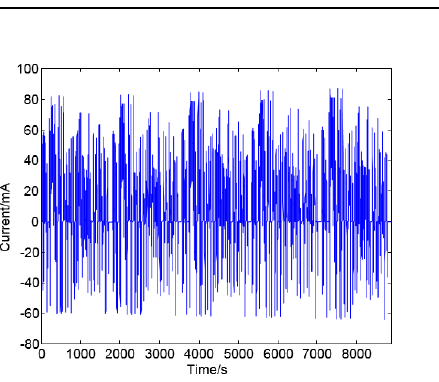
Figure 7. Fitting curves of capacity degradation at different temperatures.